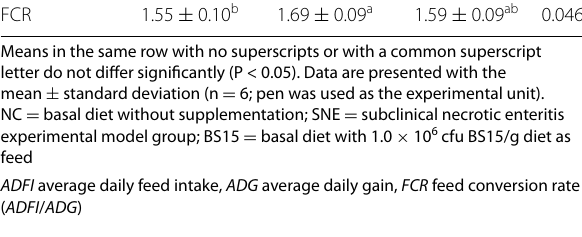
Effect of BS15 on the development and digestion of intestine effect on the level of IGF-1 and EGF in jejunum and ileum